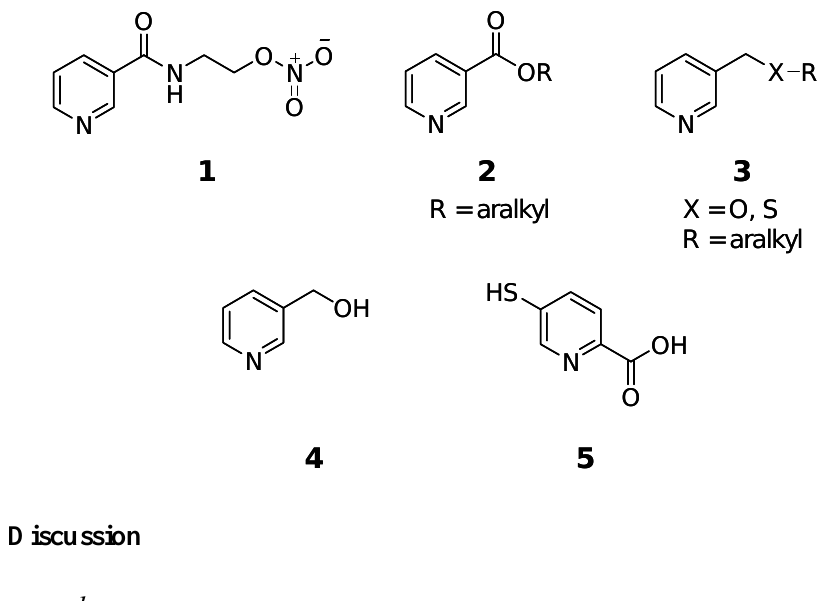
Figure 1. Chemical structure of nicotinic acid derivatives and related compounds 1 - 5